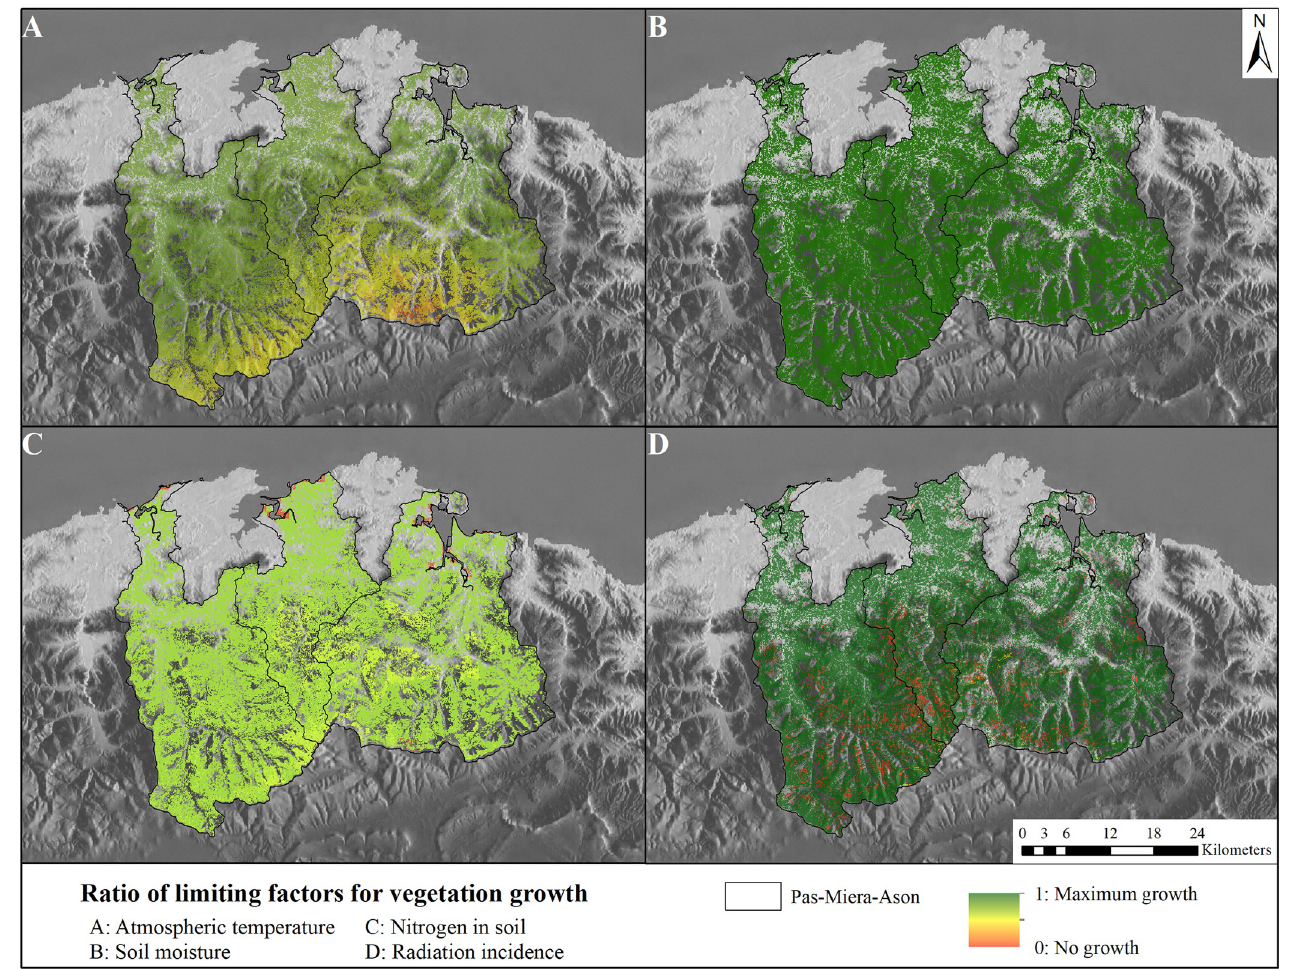
Fig 6. Modelled results of vegetation limiting factors for May 2018. All outputs range from 0 (no vegetation growth) to 1 (maximum vegetation growth). (A) Atmospheric temperature limitation. (B) Soil moisture limitation. (C) Soil nitrogen limitation. (D) Solar radiation incidence limitation. Reprinted from [67] under a CC BY license, with permission from ISPRS Journal of Photogrammetry and Remote Sensing, original copyright 2014.